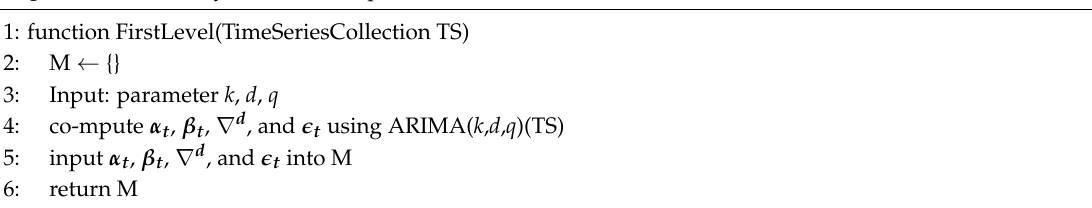
Algorithm 1. One-day-ahead model prediction for the first level.